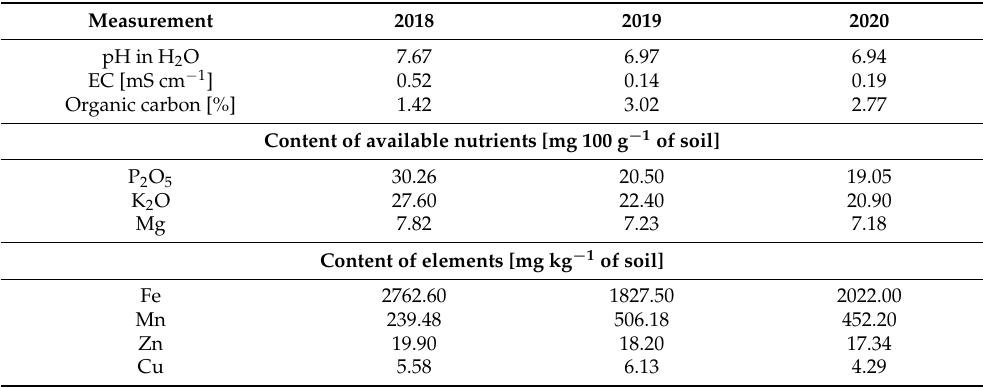
Table 1. Chemical properties of soil samples collected from the experimental field each year be- fore sowing.